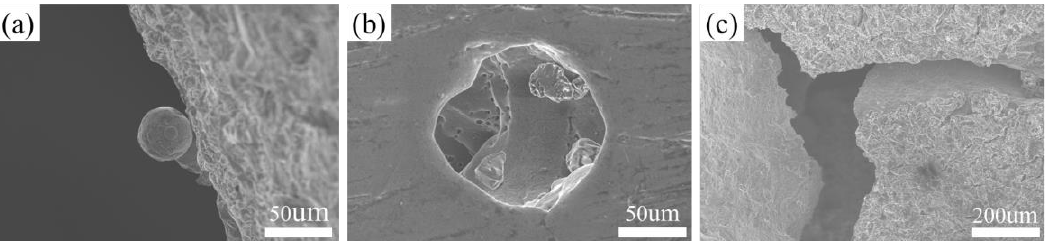
Figure 7. SEM observed the surface morphology of SLM as-built primitive specimen: ( a ) The pow-